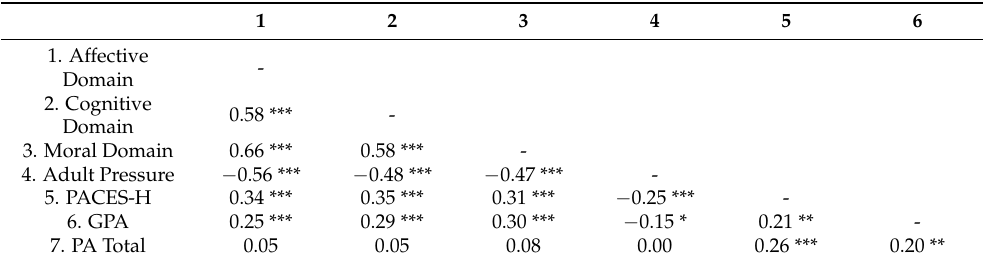
Table 3. Correlation of learning motivation, PACES-H, GPA, and physical activity. 1